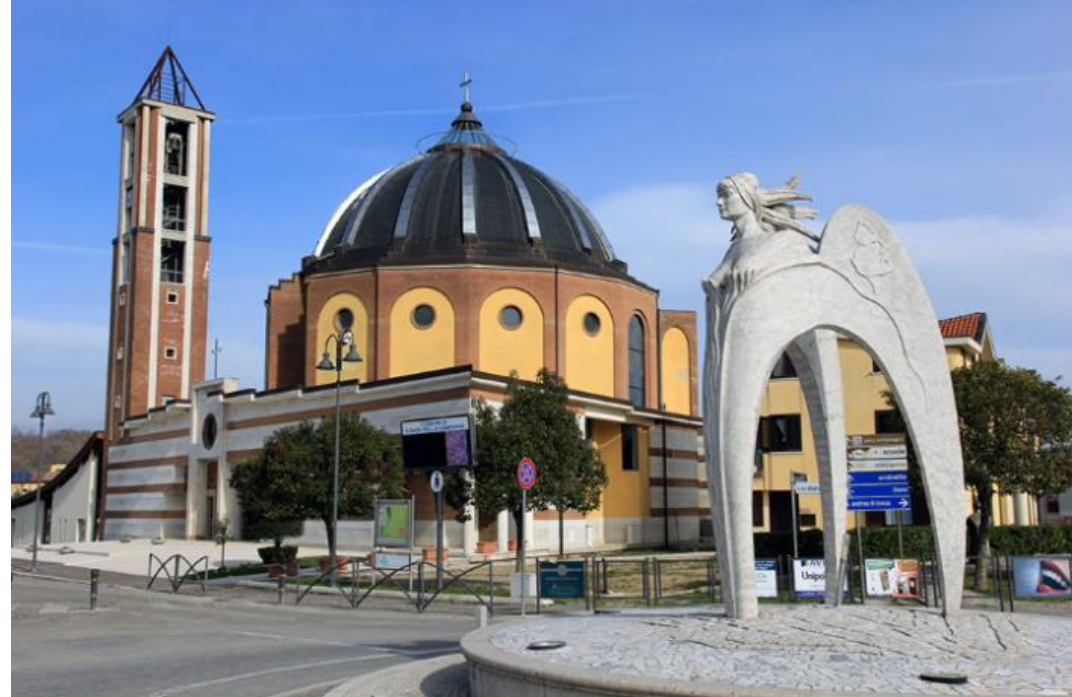
Figure 17. Conza della Campania: new village with the new Cathedral “Concattedrale di Santa Maria Assunta” in the center of village built after the 1980 earthquake (photos by [35,36]).